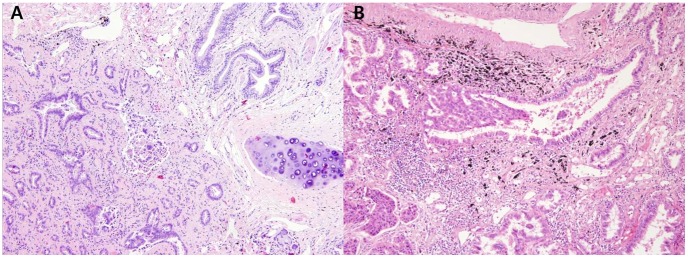
Relationship of ALK-rearranged tumors with the bronchiole.A, Tumor gland that resembles the adjacent segmental bronchial gland in morphology; B, Tumor cell infiltration of the adjacent bronchiolar epithelium.